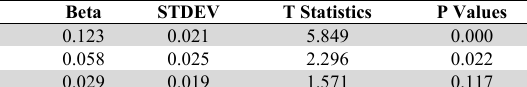
Mediation Results